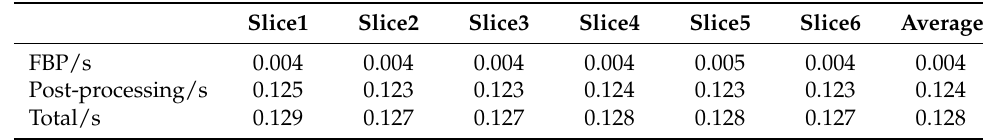
Table 6. Time consumption of different slices.